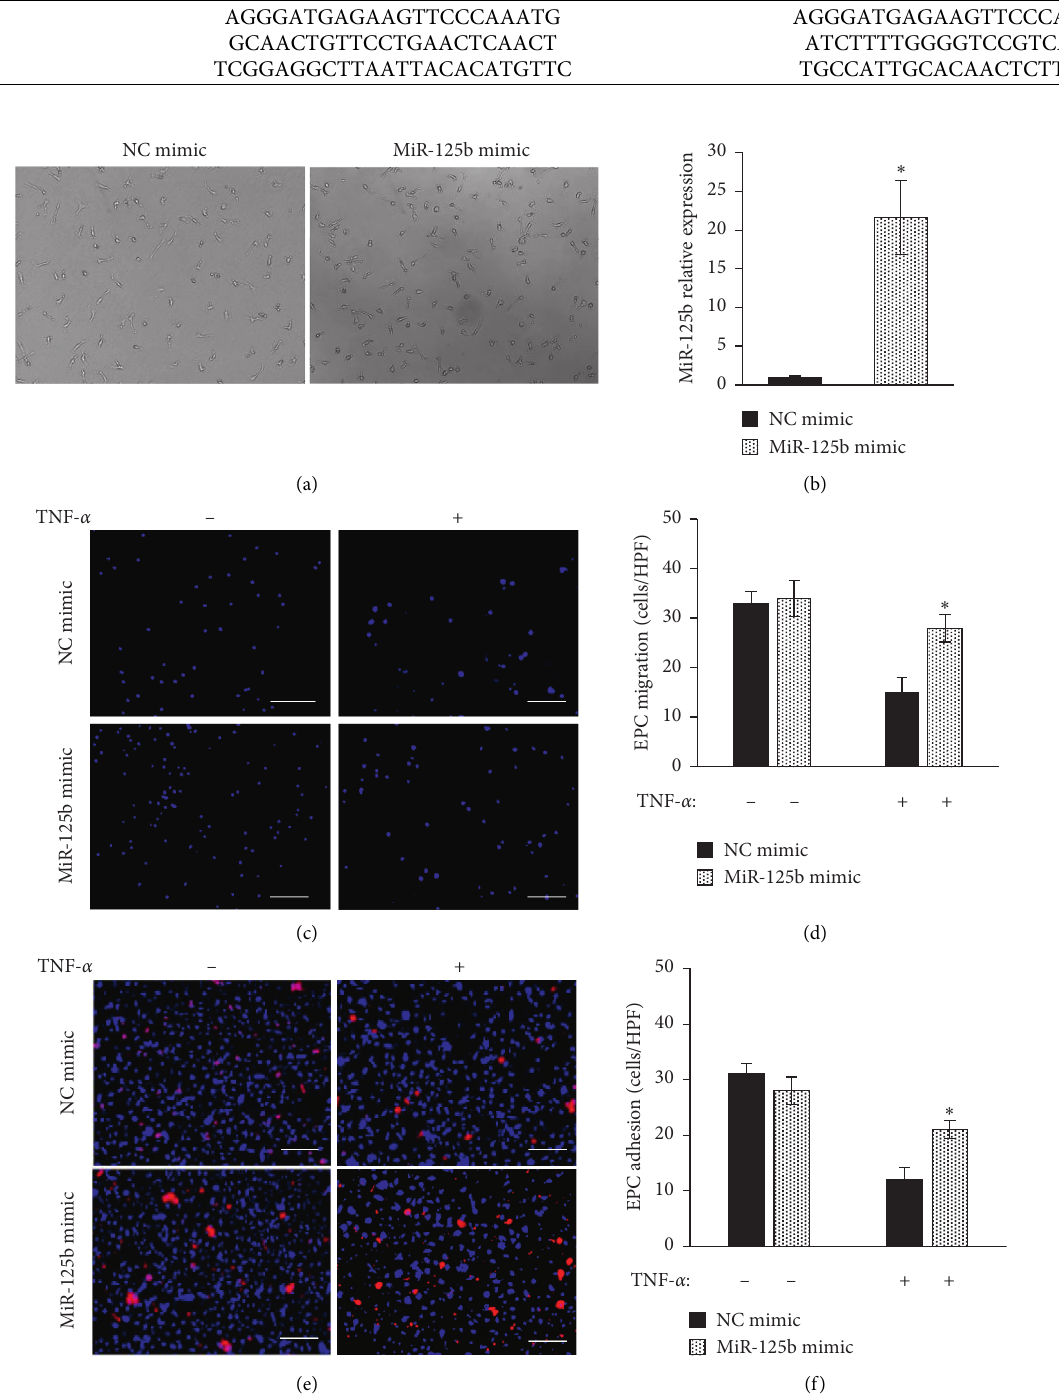
Figure 1: miR-125b overexpression in EPCs preserved its migration and adhesion function after TNF- α treatment. EPCs were transfected with miR-125b mimic and negative control mimic for 24h. (a) The level of miR125b measured by qRT-PCR (b). EPC migration and adhesion measured after transfection. Representative (c) and quantification (d) of the migratory activity of EPCs. Representative (e) and quantification (f) of DiI-labeled EPC adhesion to HUVECs with TNF- α activation (scale bar � 100 μ m, ∗ p < 0 . 05 vs. NC mimic with TNF- α treatment, n �